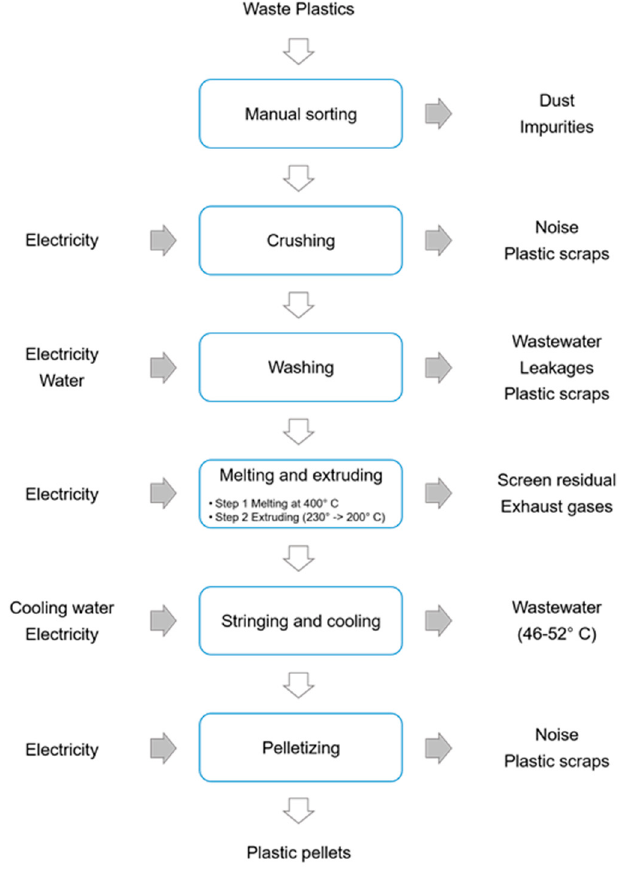
Figure 2. The plastic recycling process and related emissions at Minh Khai village [29].